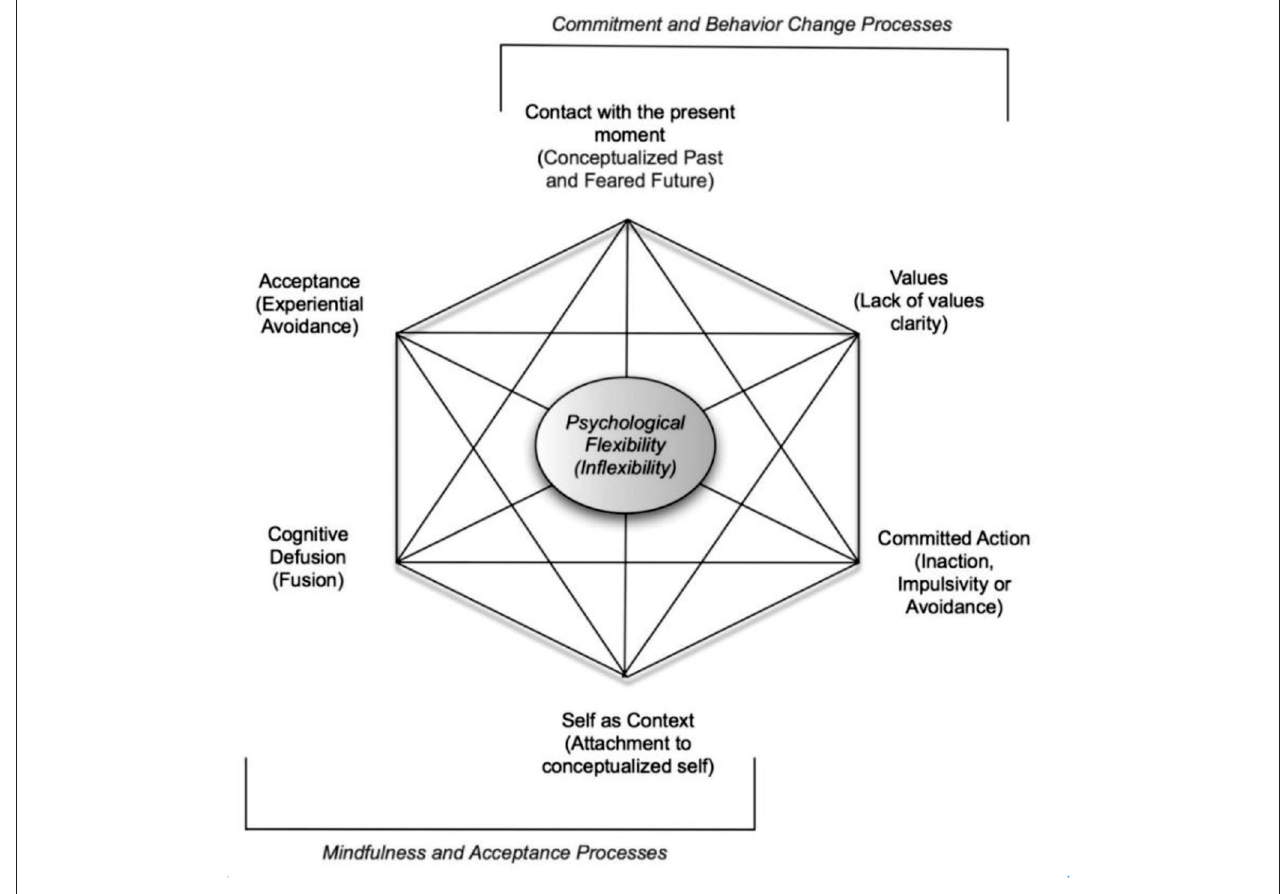
FIGURE 1 | Prevedini et al. (45). Reprinted with permission.